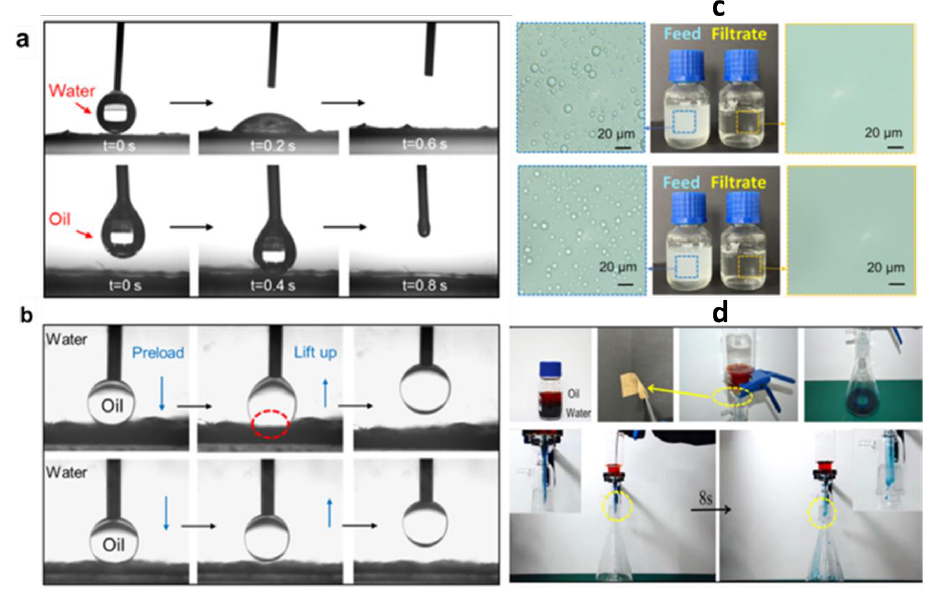
Figure 11. ( a ) Rapid water and oil spread over the membrane as shown by high-speed photography. ( b ) Dynamic images demonstrating the oil repellency and oil adhesion of CSNFMs and BC-CSNFMs while submerged in oil. ( c ) Digital photographs for silicone-in-water SFE (up) and SSE (down) before and after separation. ( d ) Demonstration of separation of immiscible oil-water mixtures. [140]. Reprinted with permission from Ref. [140] Copyright 2022 Elsevier B.V. All rights reserved.